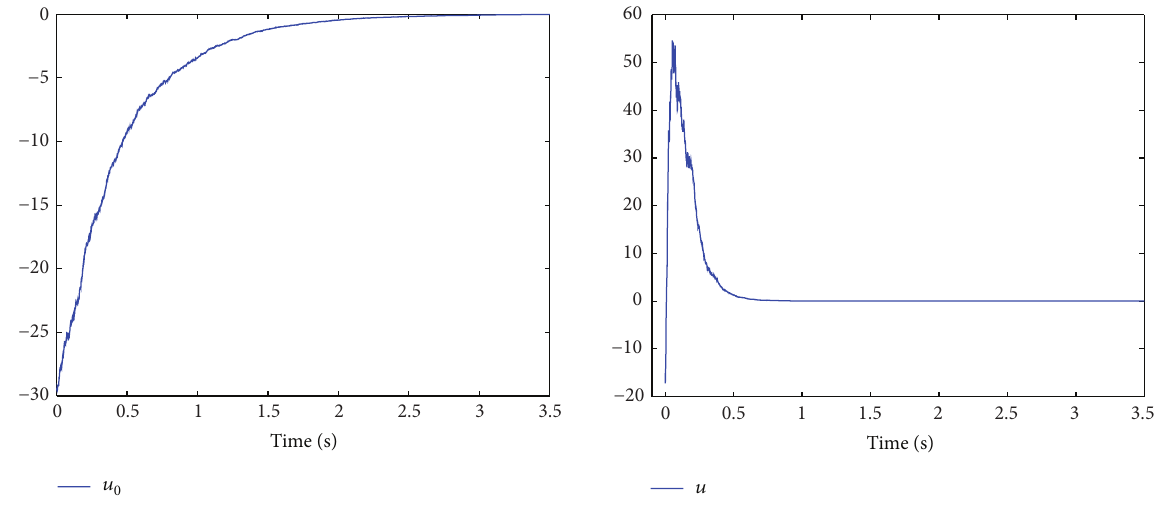
Figure 2: The responses of controllers 𝑢 0 and 𝑢 with respect to time.